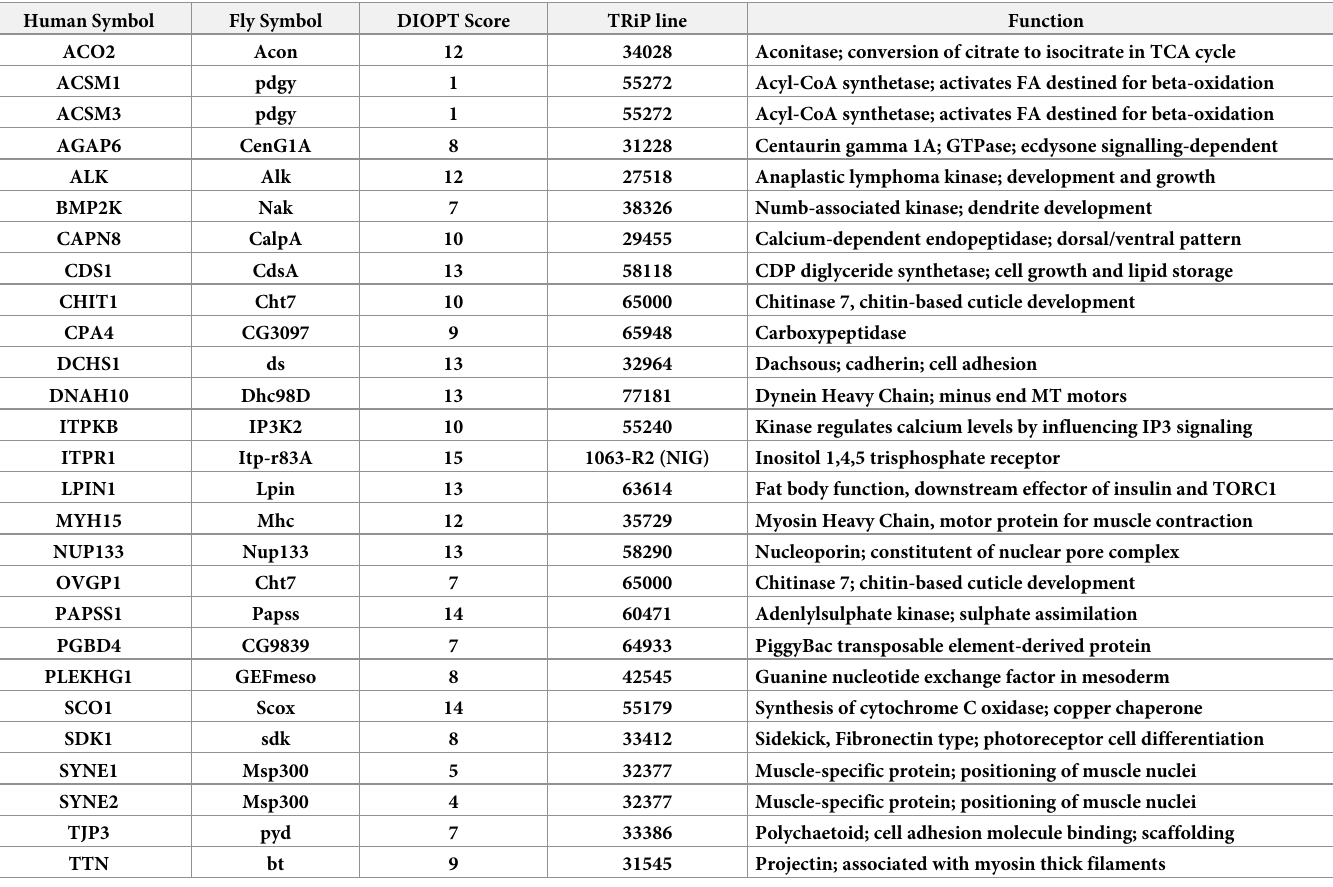
Table 1. Drosophila orthologues of candidate human obesity genes. The 24 Drosophila orthologues of 27 human genes with rare variants in obese patients, which were chosen for further study. The DIOPT score, TRiP RNAi line (except itpr (NIG line), and the function of each gene are given. Human